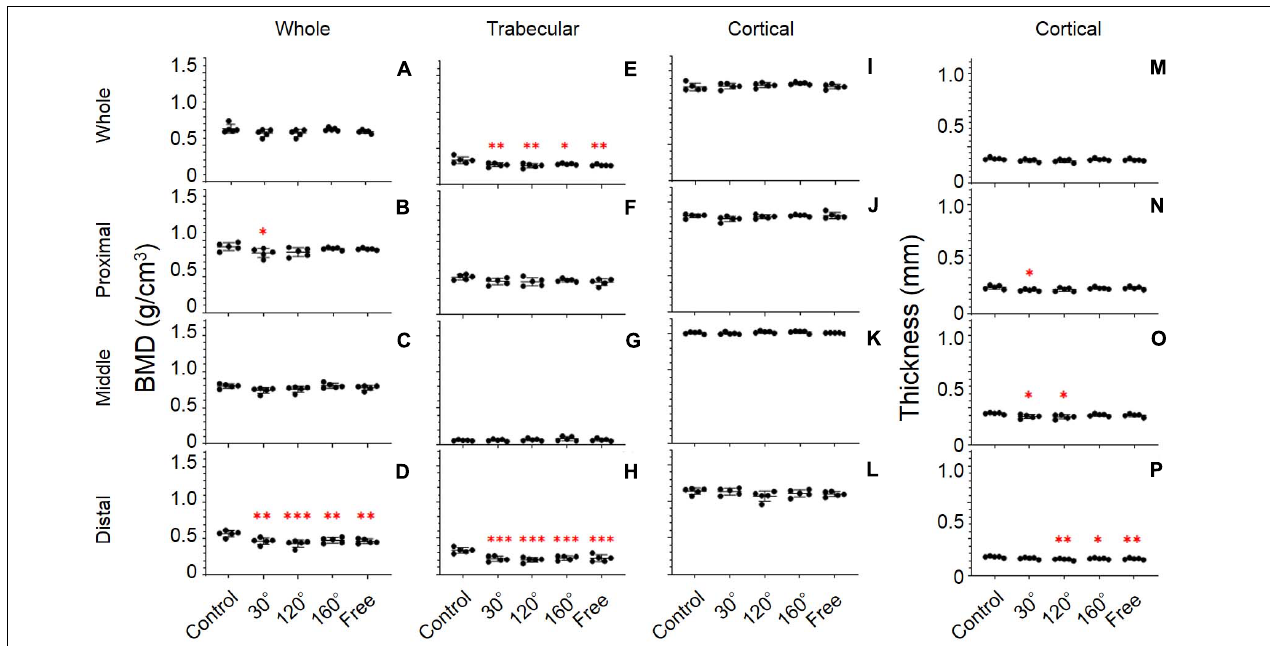
FIGURE 5 | Femoral bone parameters. The bone parameters of different femoral areas of the five tested groups are shown. (A–D) BMD, (E–H) trabecular BMD, (I–L) cortical BMD, and (M–P) cortical thickness. (A,E,I,M) Whole femur, (B,F,J,N) proximal femur, (C,G,K,O) middle femur, and (D,H,L,P) distal femur [Mean ± standard deviation (SD), n = 5. * p < 0.05 vs. the control group, ** p < 0.01 vs. the control group, *** p < 0.001 vs. the control group, one-way analysis of variance (ANOVA)].